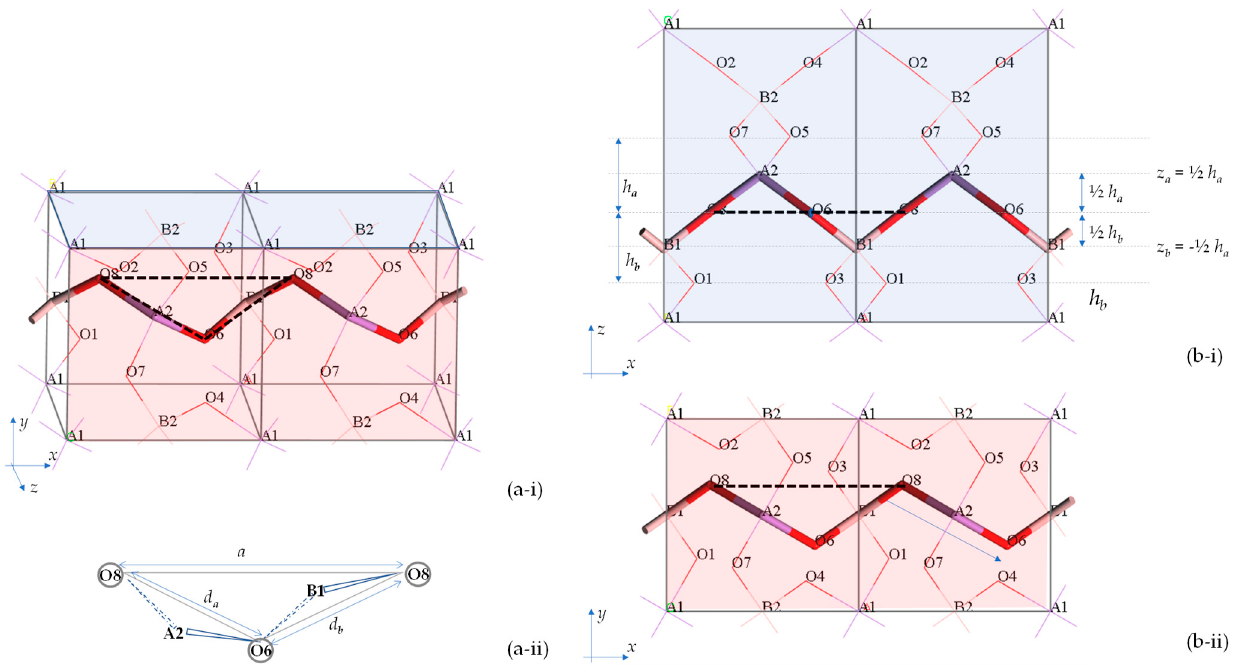
Figure 4 . The method by which the a -direction was computed from bond lengths and bond angles. ( a ) Depicts the crystal in three dimensions, where ( a-i ) shows 2 × 1 × 1 units cells and ( a-ii ) shows in more detail the relationship between the parameter a and the parameters d a and d b ; whereas ( b ) shows the same system as shown in the ( b-i ) zx- plane and ( b-ii ) xy -plane.